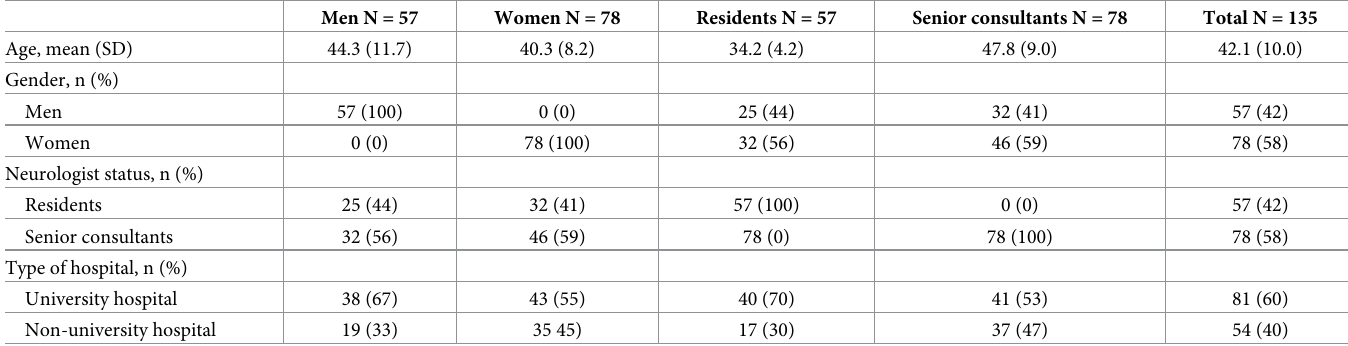
Table 1. Description of the sample (n = 135).